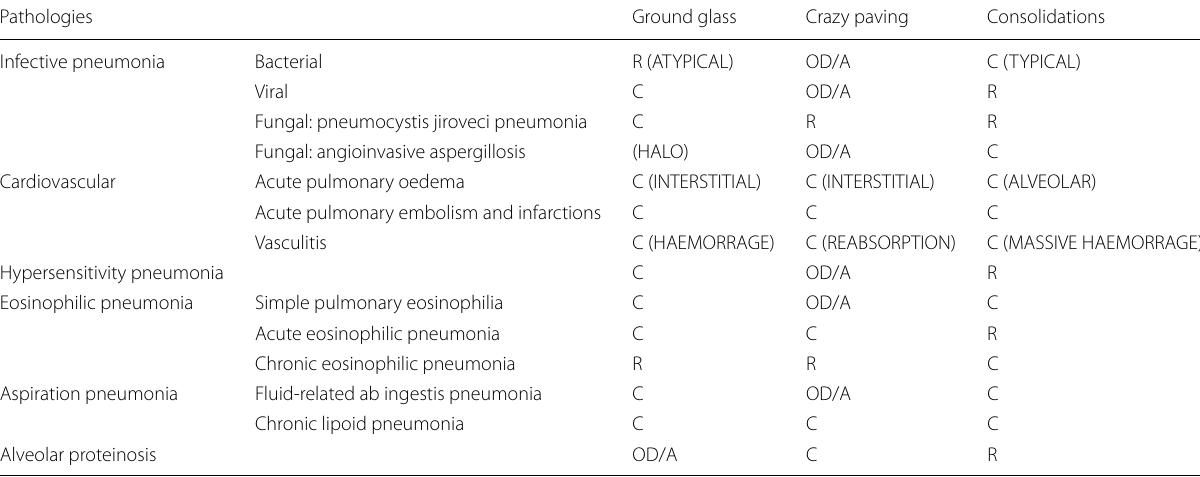
Analysed pathologies usually share at least one radiological feature, among ground-glass areas, crazy paving opacities and consolidations, with COVID-19 pneumonia. These findings may be either common or rare presentation of pathologies or be occasionally described/absent. The timing of these features presentation frequently varies with respect to COVID-19 pneumonia characteristic phases C, common; R, rare; OD/A, occasionally